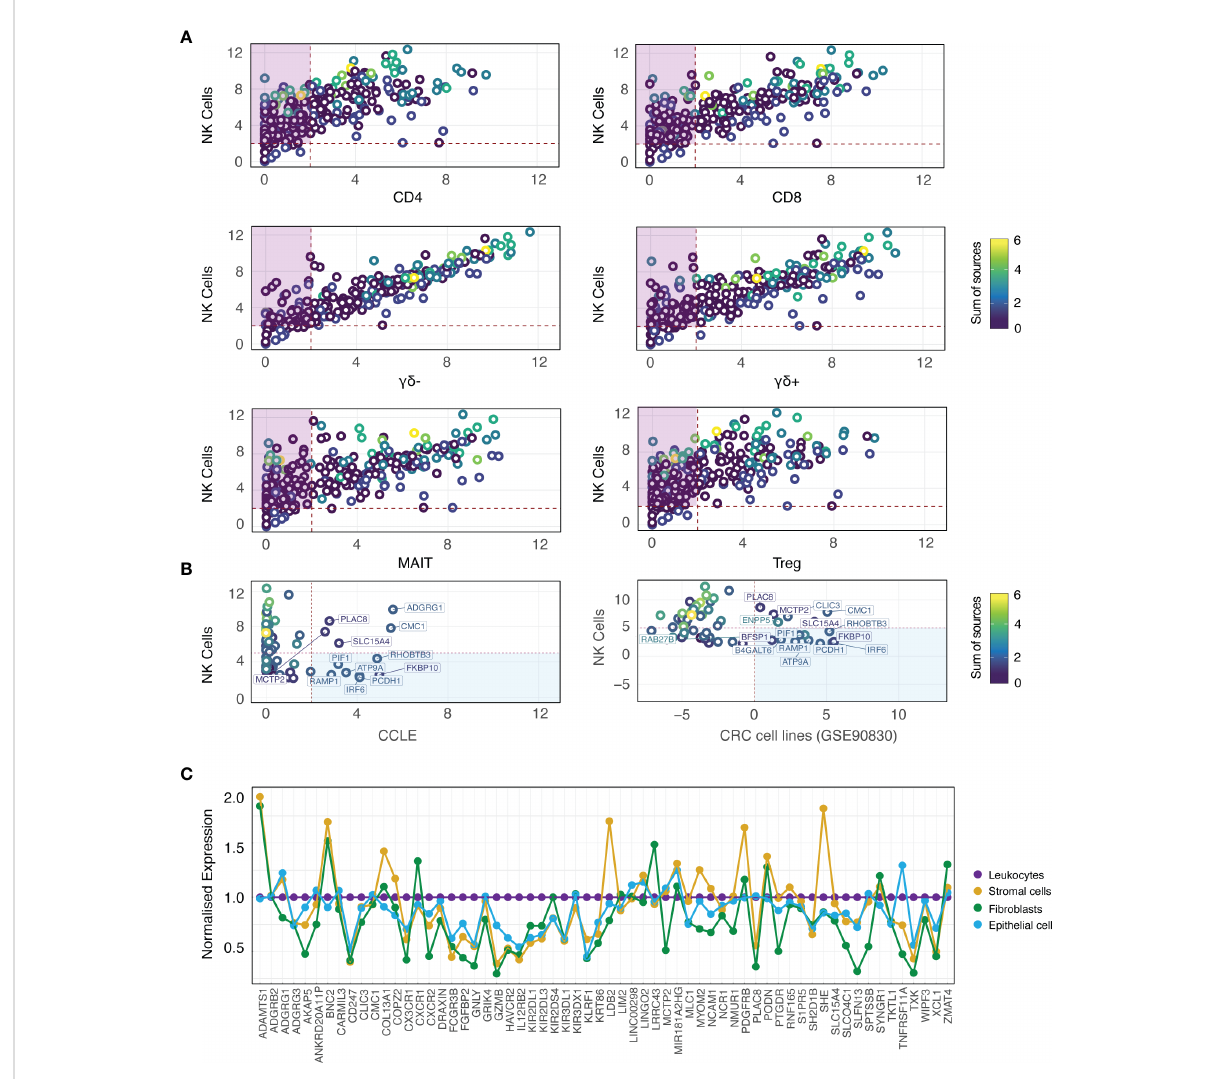
FIGURE 2 NK cell speci fi city fi ltration against immune and CRC-supportive cell types. (A) Biplots depicting median expression for each candidate gene (rings; coloured by sum of sources) in NK cells from GSE107011 (logTPM) versus other immune cell types. The intersect of passing genes for each pairwise comparison (purple boxes) were retained as candidate genes. (B) Biplots depicting median expression for each candidate gene (rings; coloured by sum of sources) in NK cells from GSE107011 (logTPM) versus CCLE CRC cell lines (left column; logRPKM) and GSE90830 (CRC cell lines; right column; logRPKM). The union offailing genes for each pairwise comparison (blue boxes; n genes = 12) were fl agged for removal from the candidate geneset. (C) Lineplot of candidate gene expression in the stromal cell (CD31+; gold), fi broblast (FAP+; green) and epithelial cell (EpCAM+; light blue) compartments of six primary CRC samples (GSE39396), normalised to leukocyte (CD45+; purple) expression. Genes with normalised expression >1 were fl agged for removal. CCLE, Cancer Cell Line Encyclopedia; CoT, CRC primary tumour; LT, CRC liver metastasis